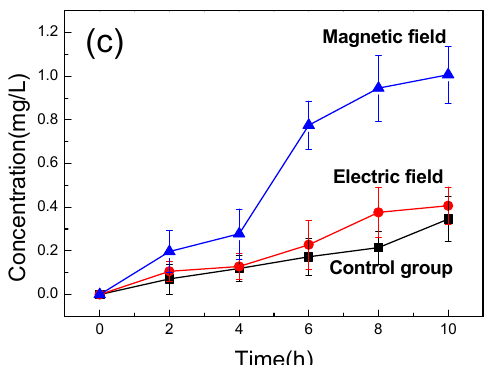
Figure 6. Change of extracellular concentration of different substances with time: ( a ) Methylene blue, ( b ) Acid orange II, and ( c ) Pyrrole structure nano-pigment